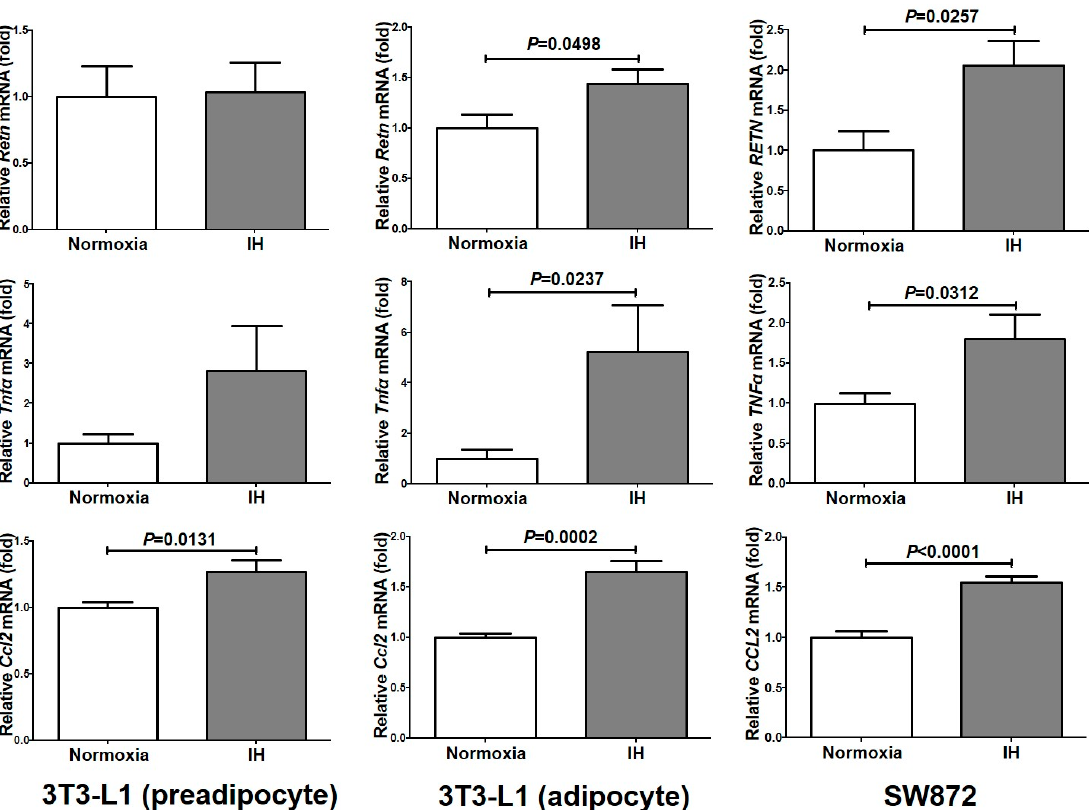
Figure 1. The mRNA levels of Retn , Tnf α , and Ccl2 in 3T3-L1 cells (preadipocyte and adipocyte) and SW872 cells treated by normoxia or IH for 24 h. The levels of the adipokine mRNAs were measured by real-time RT-PCR using Rig / RpS15 (in mouse) and β -actin (in human) as an endogenous control. Data is expressed as mean ± SE for each group ( n = 4). The statistical analyses were performed using Student’s t -test. On the other hand, the mRNA levels of IL-6 were significantly increased only in 3T3-L1 adipocytes ( P = 0.0456), and unchanged in 3T3-L1 preadipocytes and SW872 cells ( P = 0.3246 and P = 0.9366, respectively). Adip mRNA was significantly decreased in SW872 cells ( P = 0.0376), and unchanged in either 3T3-L1 preadipocytes or adipocytes ( P = 0.5787 and P = 0.7094, respectively). In all the analyzed cells, the mRNA levels of Lep were not significantly changed by IH ( P = 0.2359 in 3T3-L1 preadipocytes, P = 0.4411 in 3T3-L1 adipocytes, and P = 0.3728 in SW872 cells) (Figure 2). Considering these results, IH stress might specifically up-regulate expression of Retn , Tnf α and Ccl2 in 3T3-L1 adipocytes and SW872